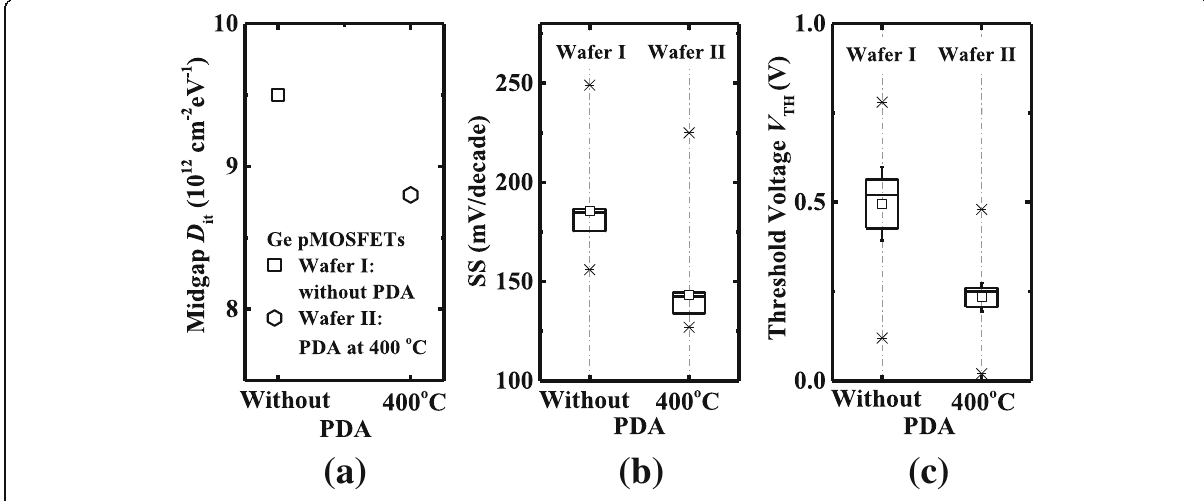
Fig. 8 Comparison of a midgap D it , b SS, and c V TH for Ge pMOSFETs on wafer I and II with PMA at 400